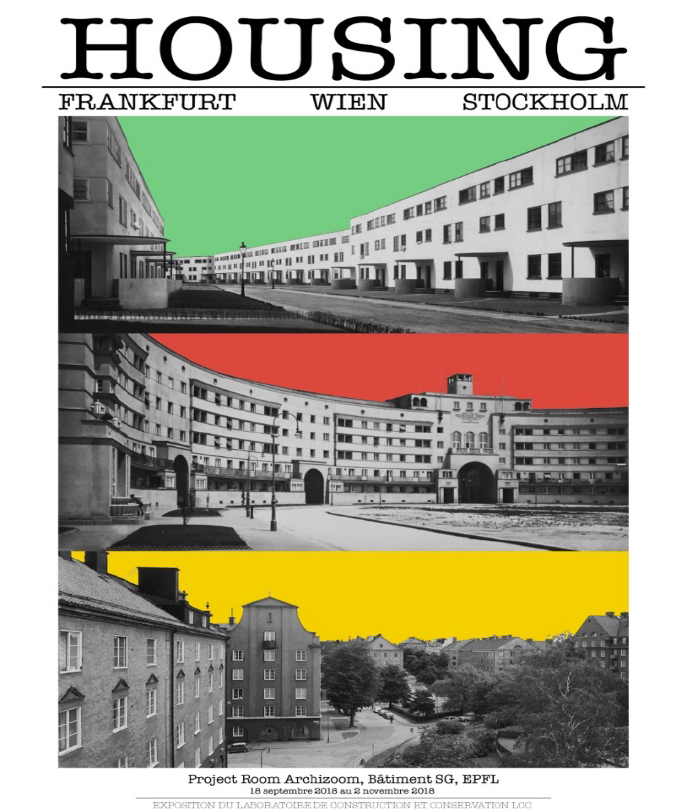
Figure 1. Poster of the exhibition “HOUSING Frankfurt Wien Stockholm”. Source: Authors. (LCC; see https://www.epfl.ch/labs/lcc), under the